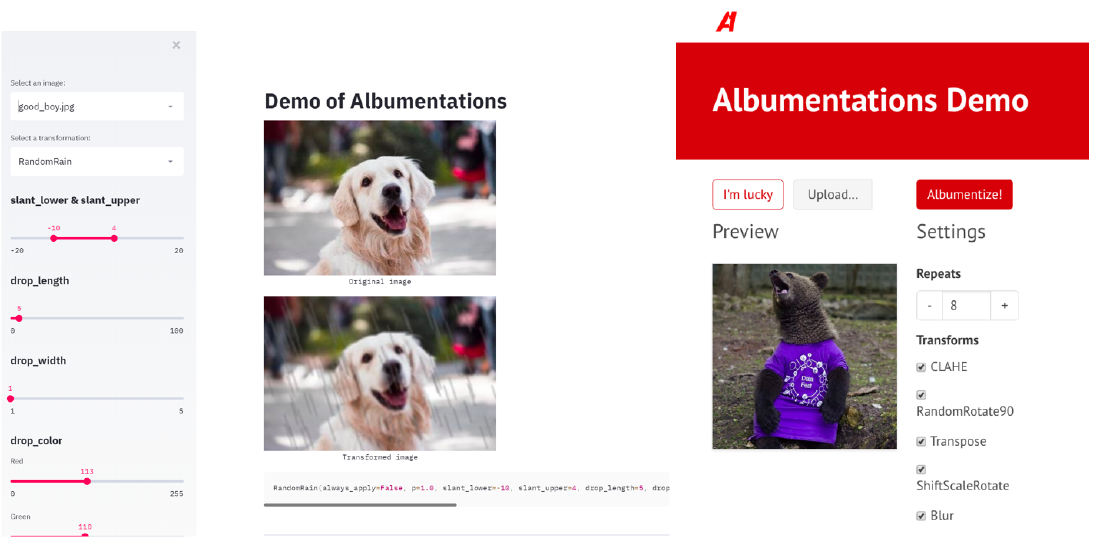
Figure 6. Community-developed tools to visualize the results of image transforms implemented in Albumentations: ( left ) visualization of a single transform with the ability for parameter tuning [71]; and ( right ) visualization of a chained number of transforms